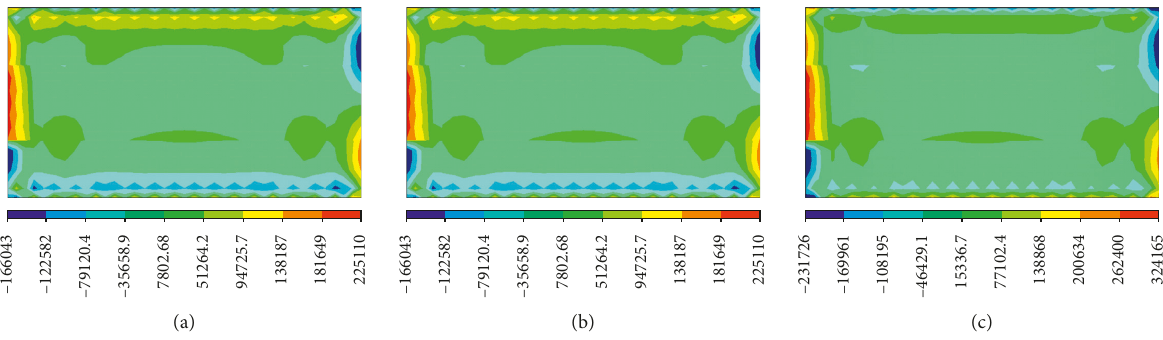
Figure 23: Tangential stress of interface under condition 1. (a) P